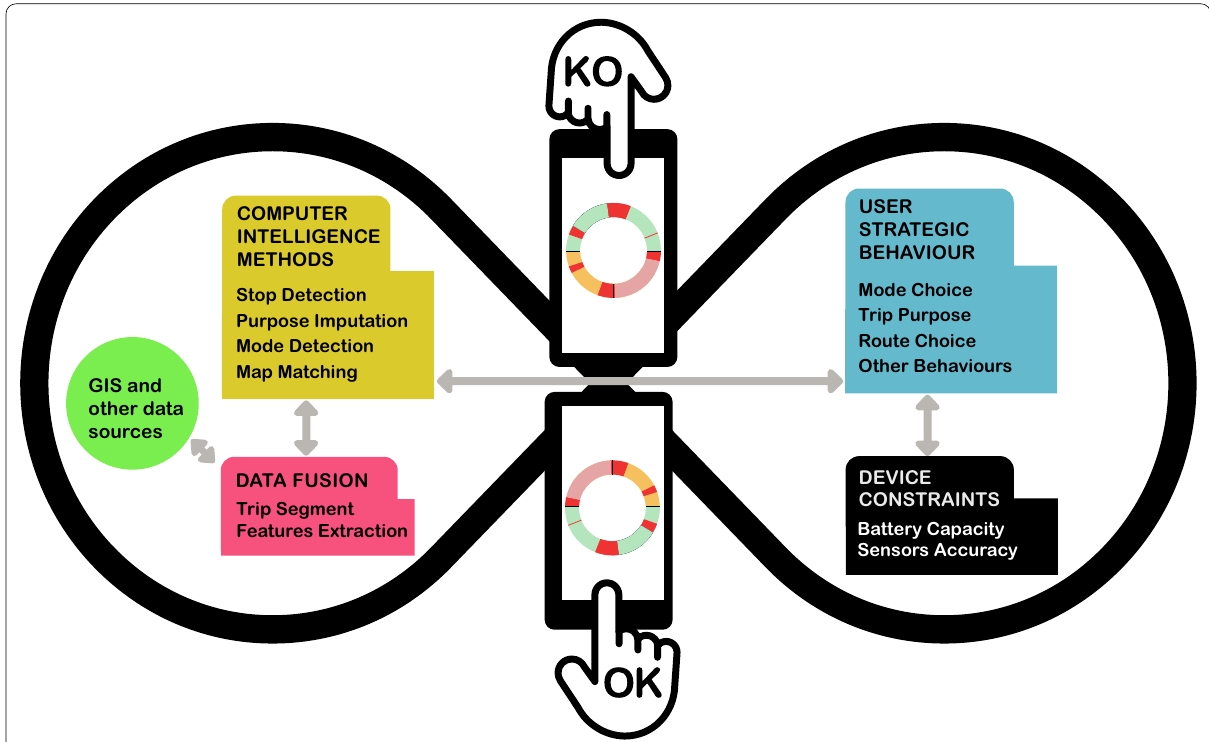
Fig. 3 Validation loop in smartphone-based user activity